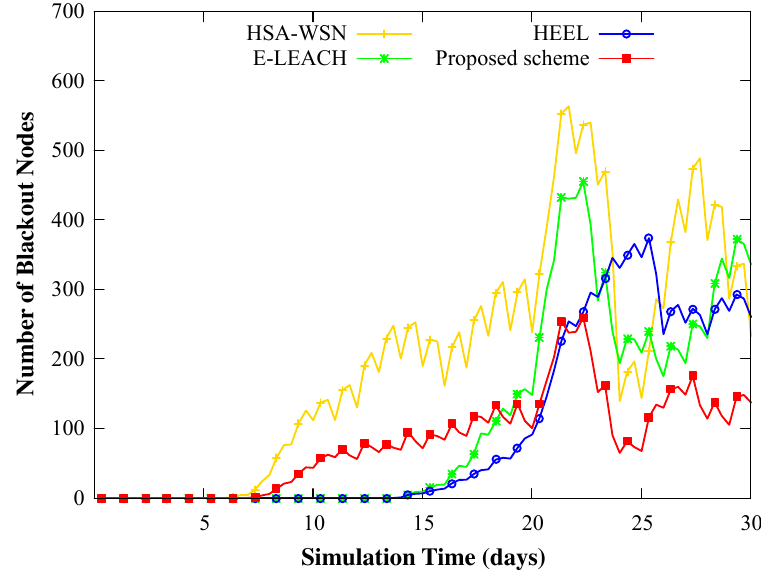
Figure 7. The change in the number of blackout nodes when simulating with 1600 nodes (21st–22th: rainy, 26th–27th: cloudy, and other: